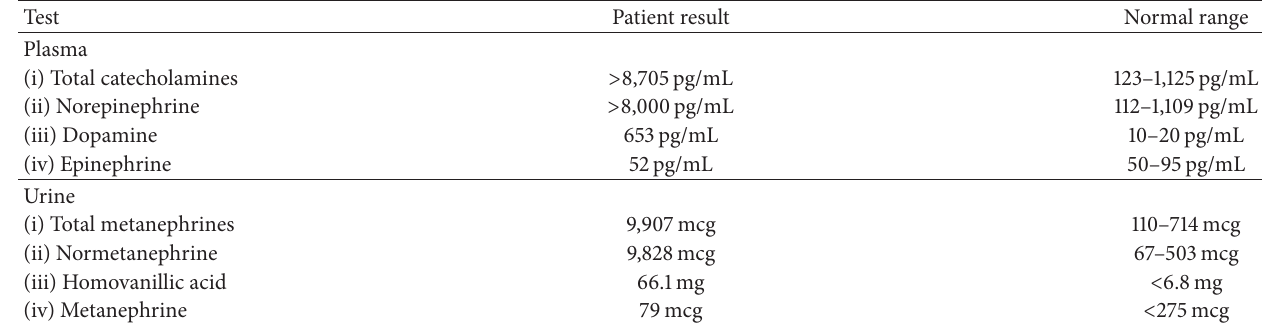
Table 1: Presenting serum and urine catecholamine